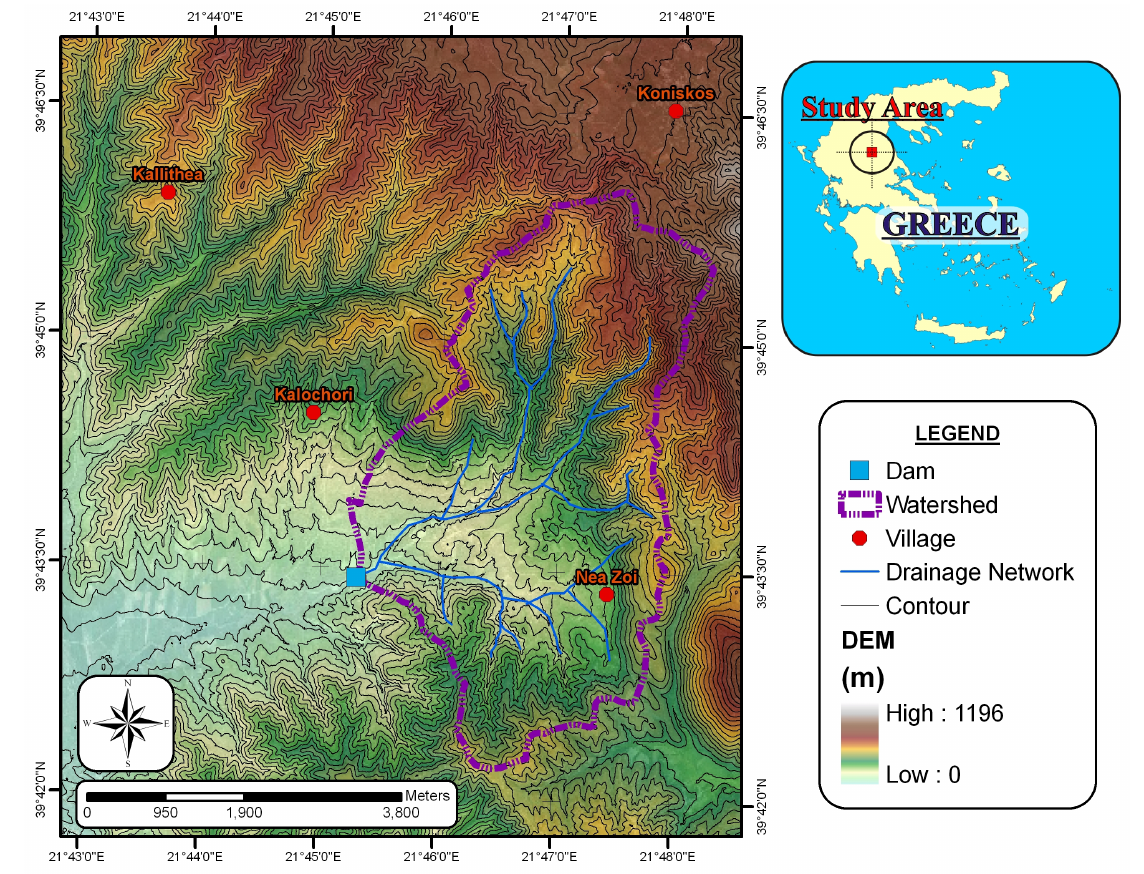
Figure 2. The study site: watershed, rivulet network, digital elevation model (DEM), dam and consumption points